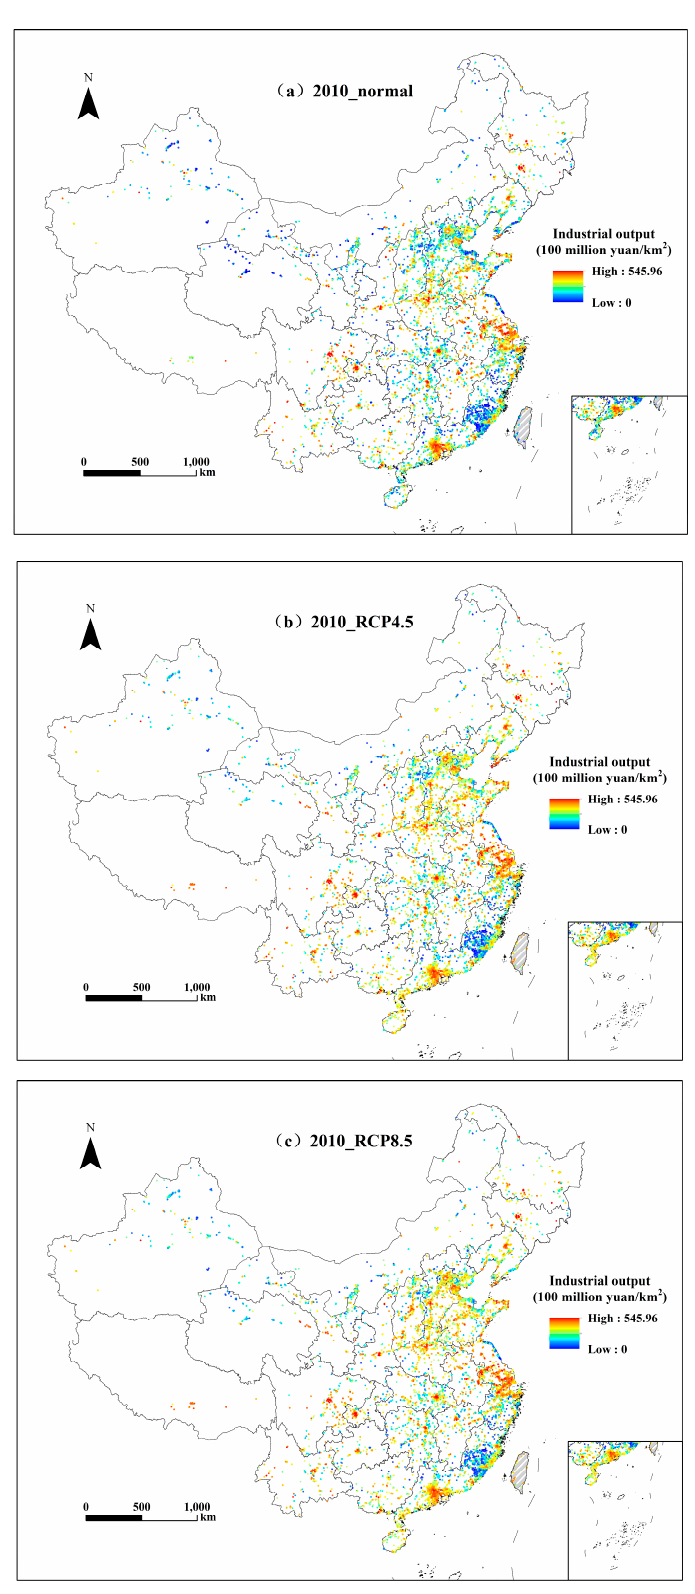
Figure 4. Spatial distribution diagrams of the proportions of China’s industrial output in 2010 under the scenarios of normal condition ( a ), RCP4.5 ( b ), and RCP8.5 ( c